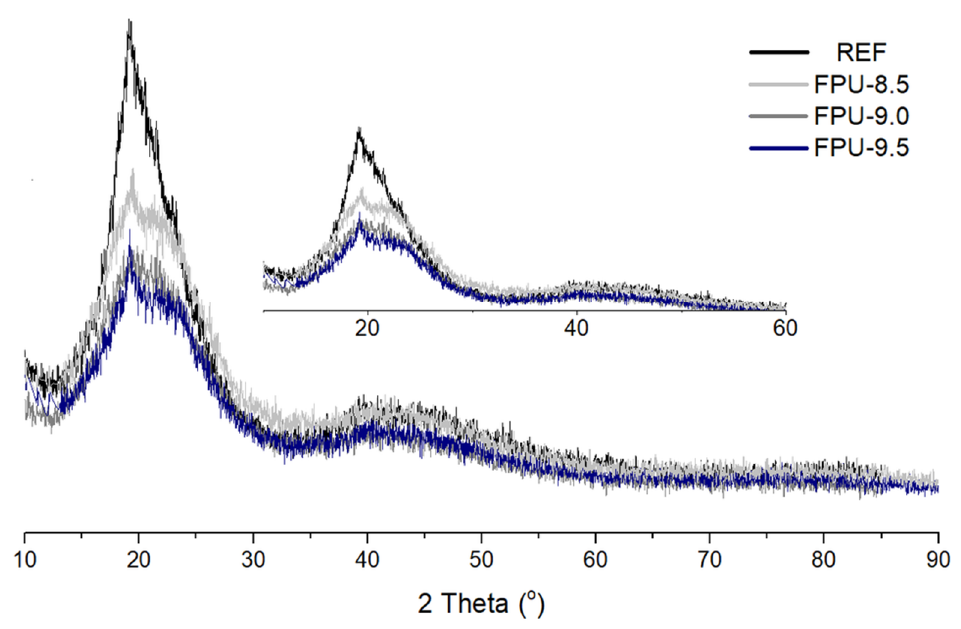
Figure 3. XRD results of the obtained materials.